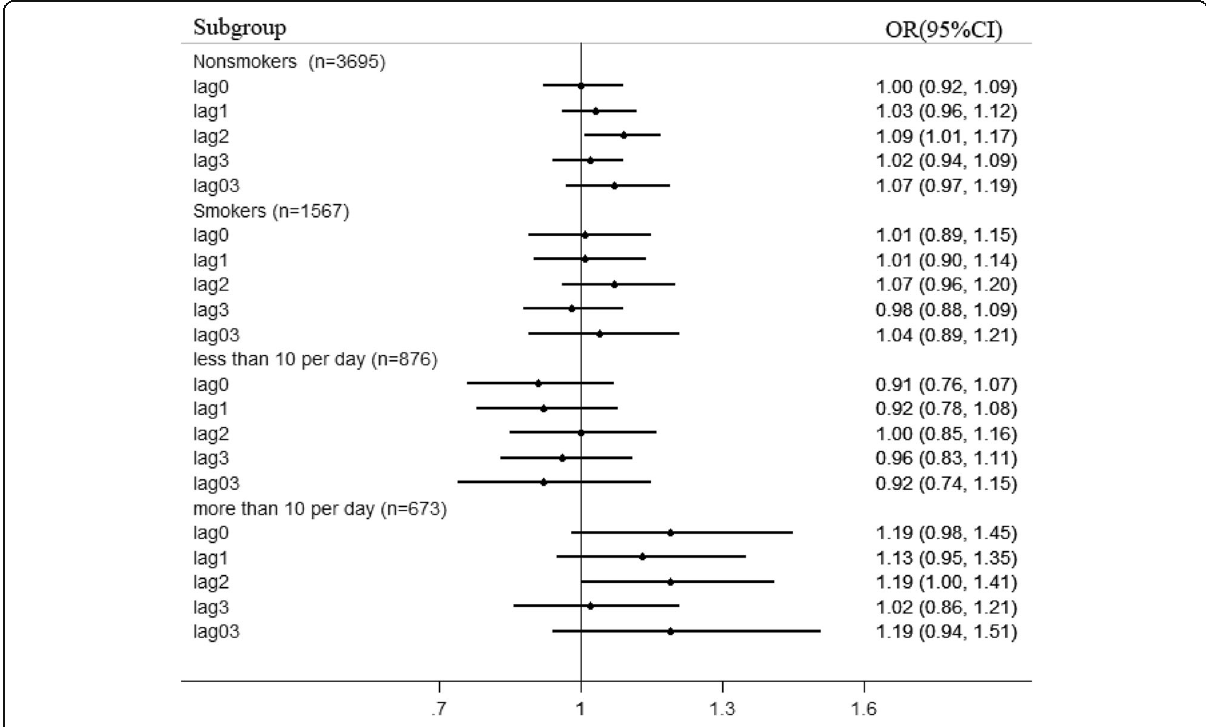
Fig. 1 Effect modification by smoking status and amount of cigarette